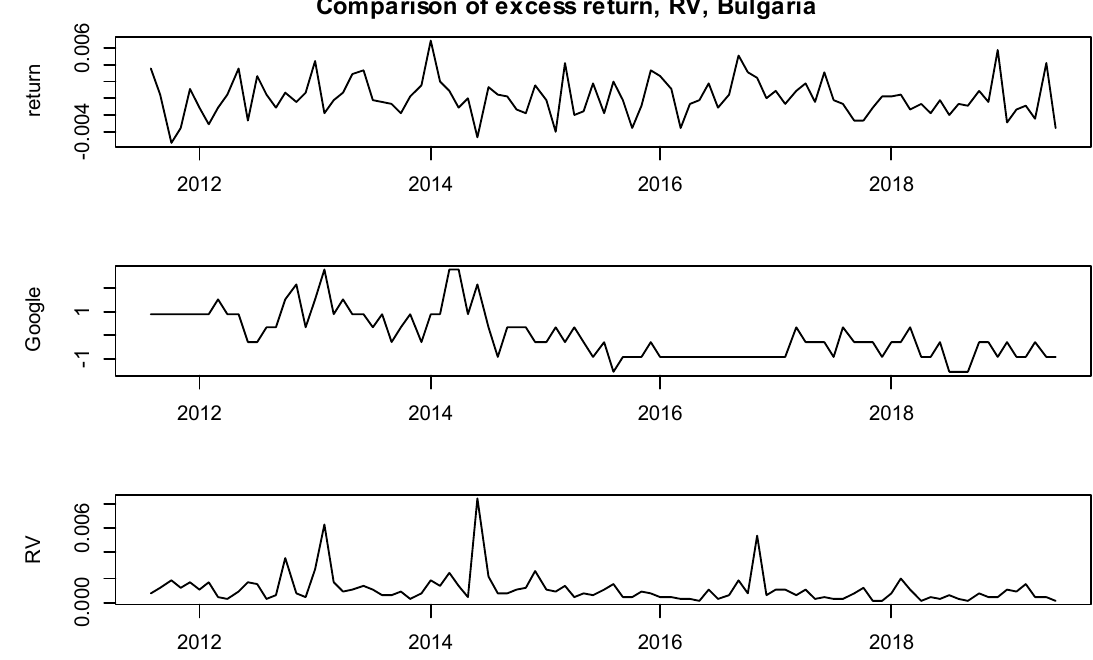
Figure A9. Comparison of monthly series: Excess return, RV and Google search volume, Bulgaria.